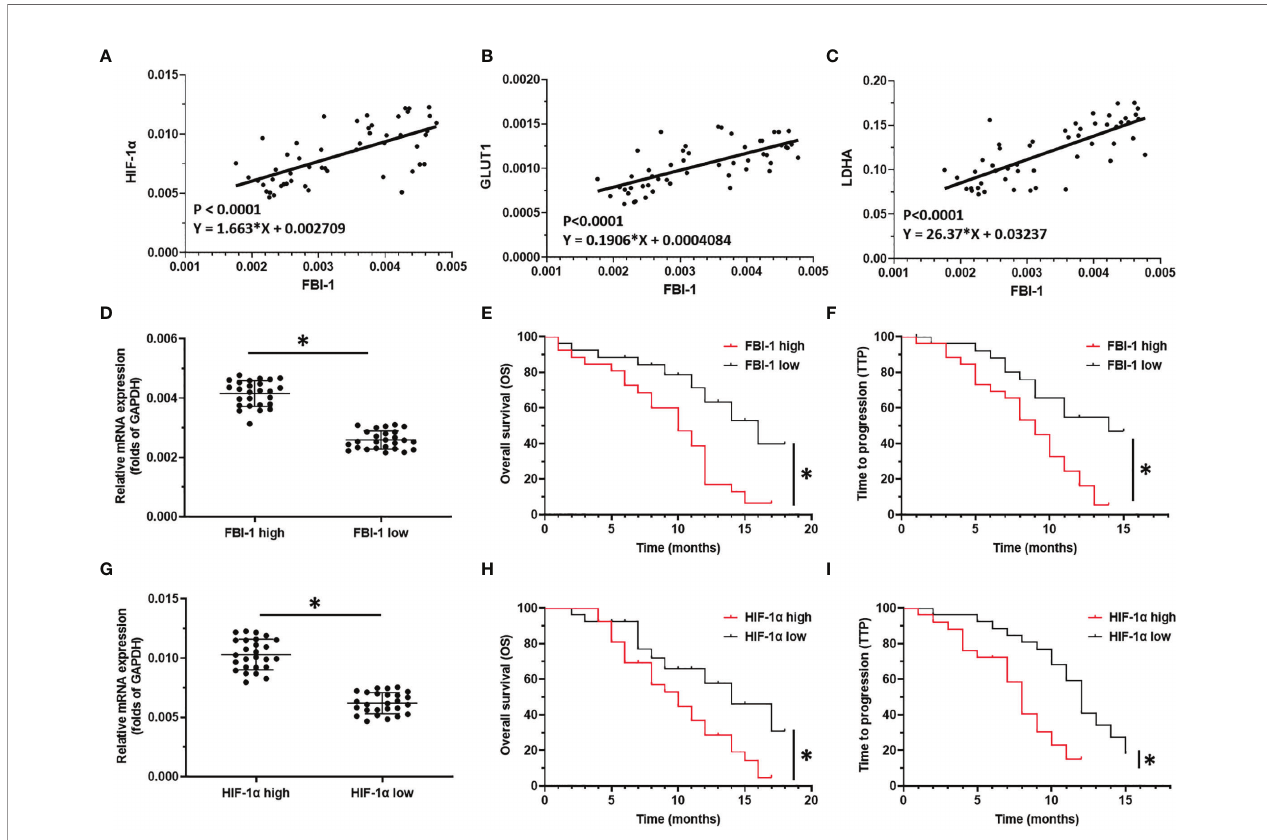
FIGURE 2 | The clinical signi fi cance of FBI-1/HIF-1 a axis in HCC. (A – C) The correlation between FBI-1 with HIF-1 a -pathway-related factors. (D – F) The correlation between FBI-1 with advanced HCC patients who received sorafenib. (G – I) The correlation between HIF-1 a with advanced HCC patients who received sorafenib. *p < 0.05.